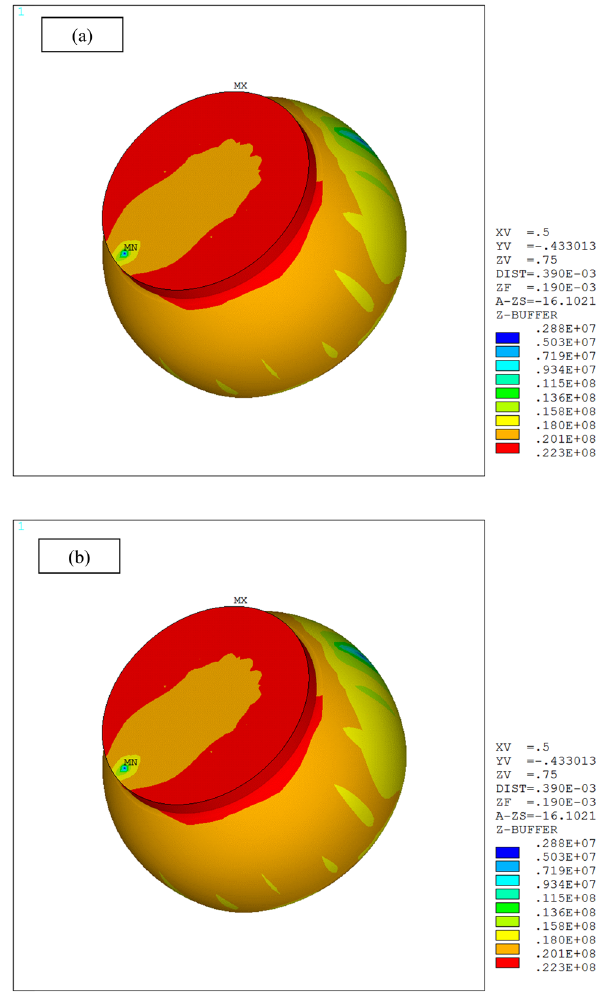
Figure 8: Critical solder joints von Mises stress distributions in ( a ) full and ( b ) peripheral